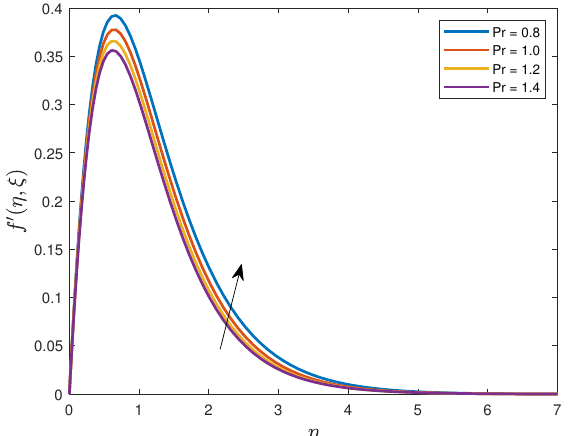
Figure 16. The influence of Pr on fluid